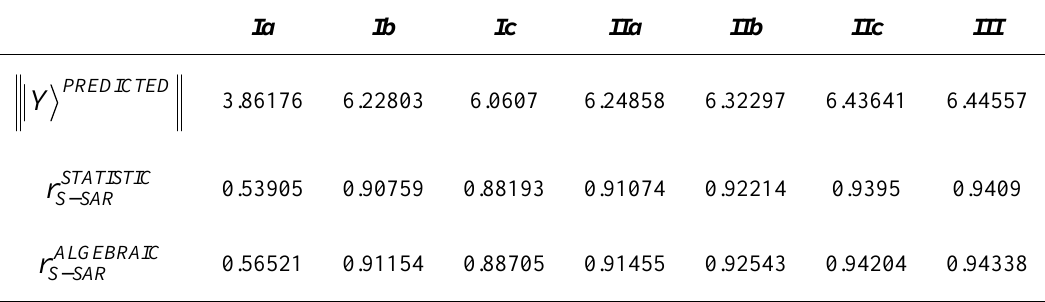
Table 6. The predicted spectral norm, the statistic and the algebraic correlation factors of the S-SAR models of Table 5, computed upon the general Eqs. (30), (21), and (31) since the entry data of Table 3 are employed,